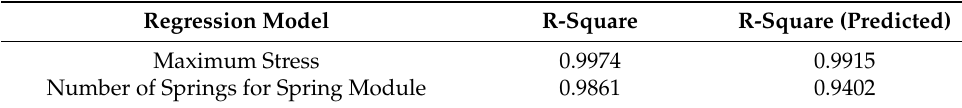
Table 5. Goodness of fit for Regression Model.